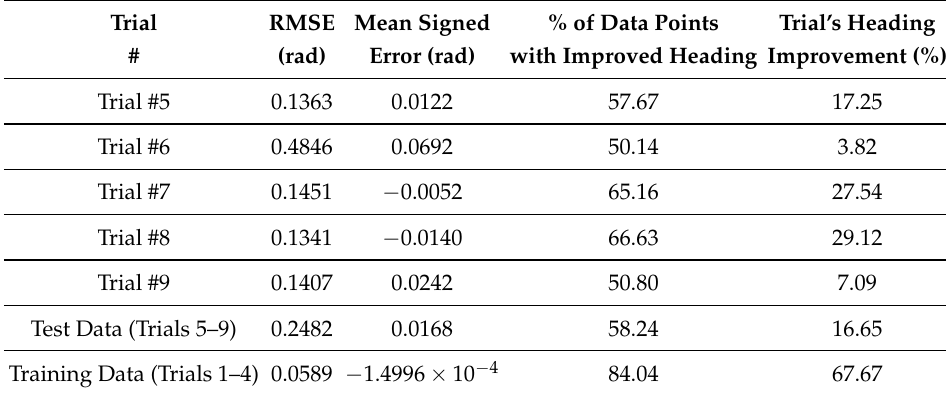
Table 10. Performance of heading correction